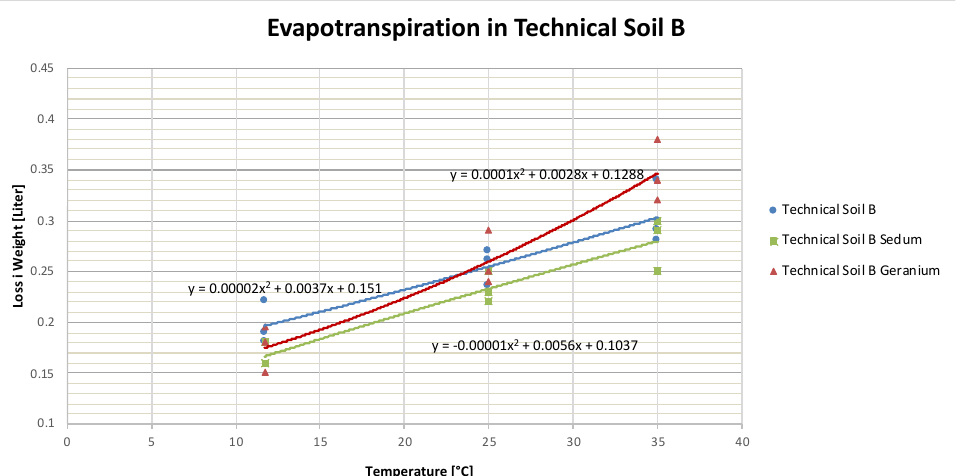
Figure 2. Regression lines were inserted through the differences in weight of any soil combination of technical soil A (with and without planting) in climate scenario I, II, and III, to create equations for calculating evapotranspiration (based on Weiss, 2017 [40]).